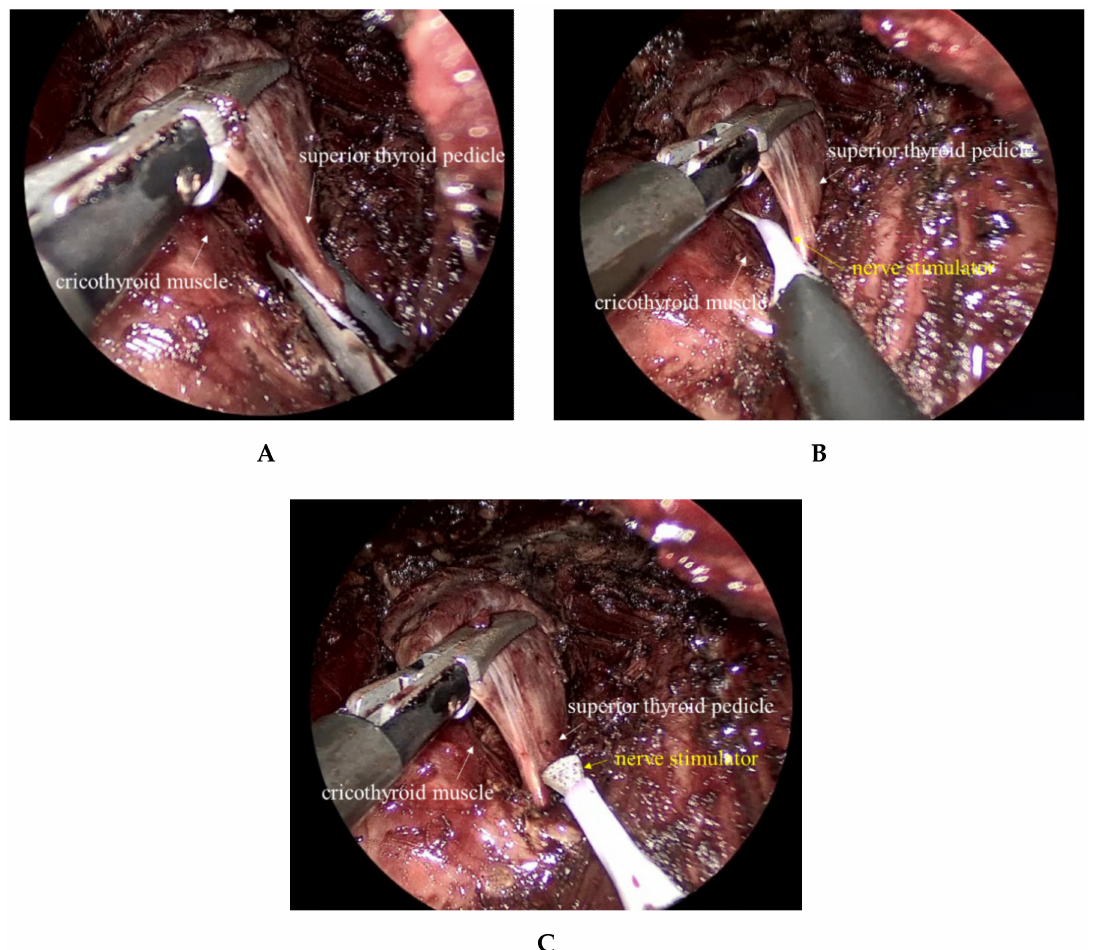
Figure 3. Right superior pole dissection during the transoral endoscopic thyroidectomy vestibular approach (TOETVA). ( A ) The external branch of the superior laryngeal nerve (EBSLN) can be damaged by the energy device during ligation of the superior thyroid vessels. The use of intraoperative neural monitoring during TOETVA: ( B ) a nerve stimulator is placed between the superior thyroid pedicle and the cricothyroid muscle (CTM) to stimulate the EBSLN, causing the CTM to visibly twitch (true positive stimulation). ( C ) The stimulator is then applied to the superior thyroid pedicle (negative stimulation of the EBSLN) (true negative